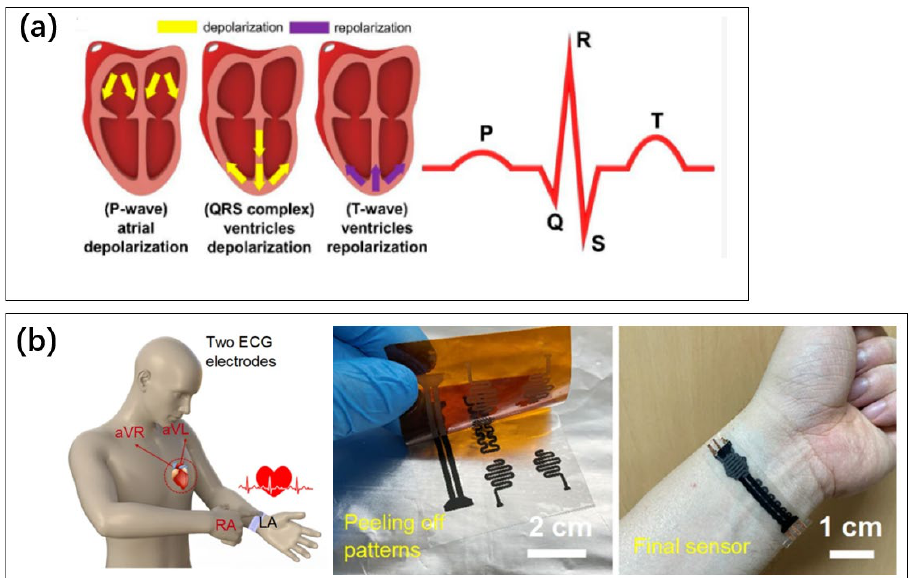
Figure 7. ( a ) The different phases of muscle movement during the heartbeat produce different parts of the ECG curve. The depolarization and repolarization of the heart for the generation of a P-wave, QRS complex, and T-wave [85]. Reproduced under the terms of the CC-BY Creative Commons Attribution License, Copyright 2022 by the authors, published by MDPI. ( b ) A flexible skin electrode sensor. Monitoring ECG at the wrist [90]. Reproduced under the Creative Commons Attribution 4.0 International License, Copyright 2022 by the authors, published by Nature